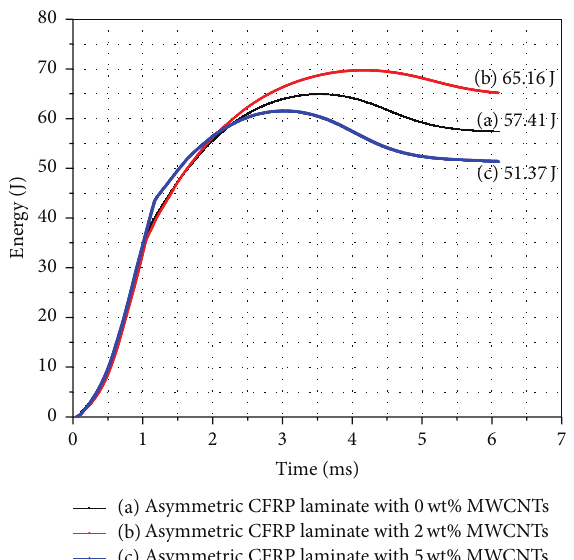
Figure 3: Energy-time relation of asymmetric CFRP laminate embedded with 0 wt.%, 2 wt.%, and 5wt.%